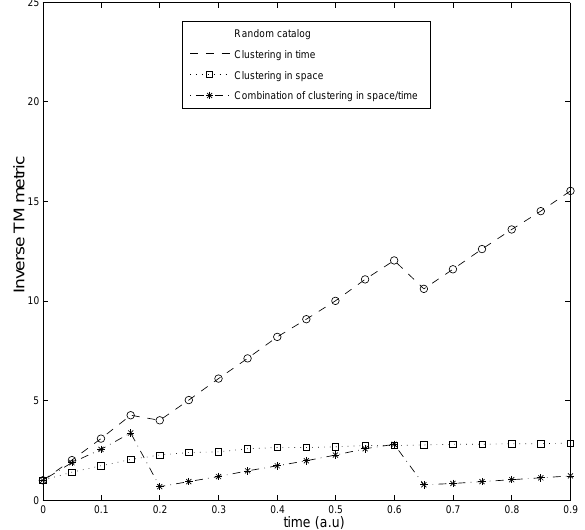
Fig. 2. Inverse TM metric for the different scenarios described in Fig. 1. From the uppermost to the lowermost solid line: random catalog, temporal clustering only, spatial clustering only, and the combination of both temporal and spatial clustering.